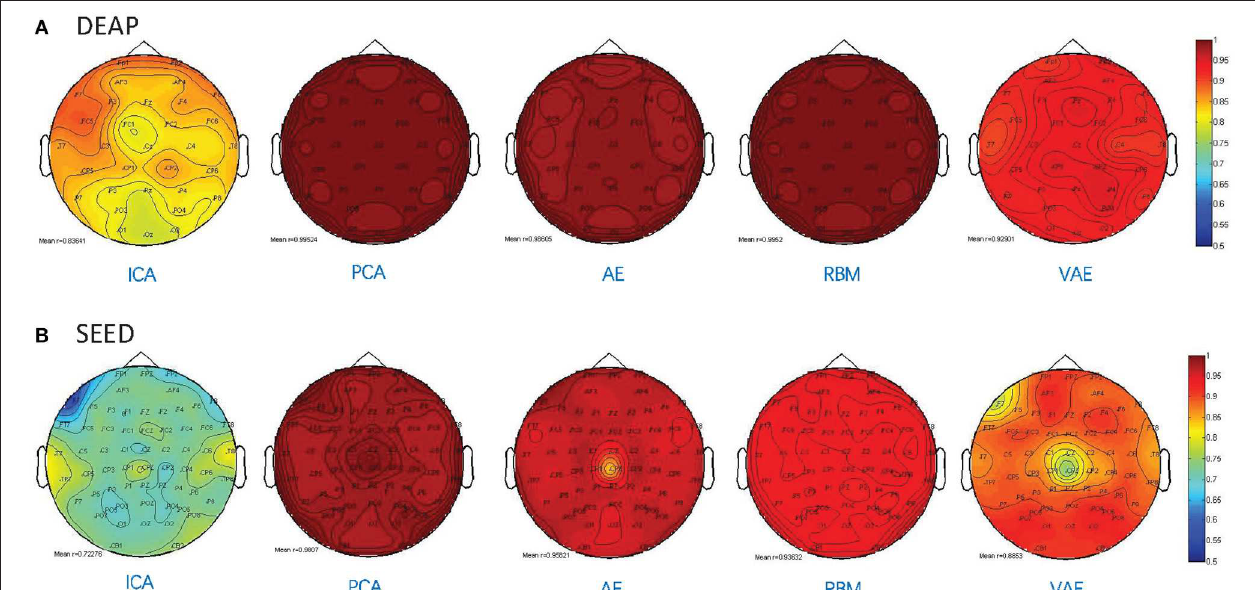
FIGURE 5 | Pearson correlation coefficient between the reconstructed EEG signal and the original EEG signal for each channel. (A) The reconstruction performance of different methods on DEAP dataset. (B) The reconstruction performance of different methods on SEED dataset.